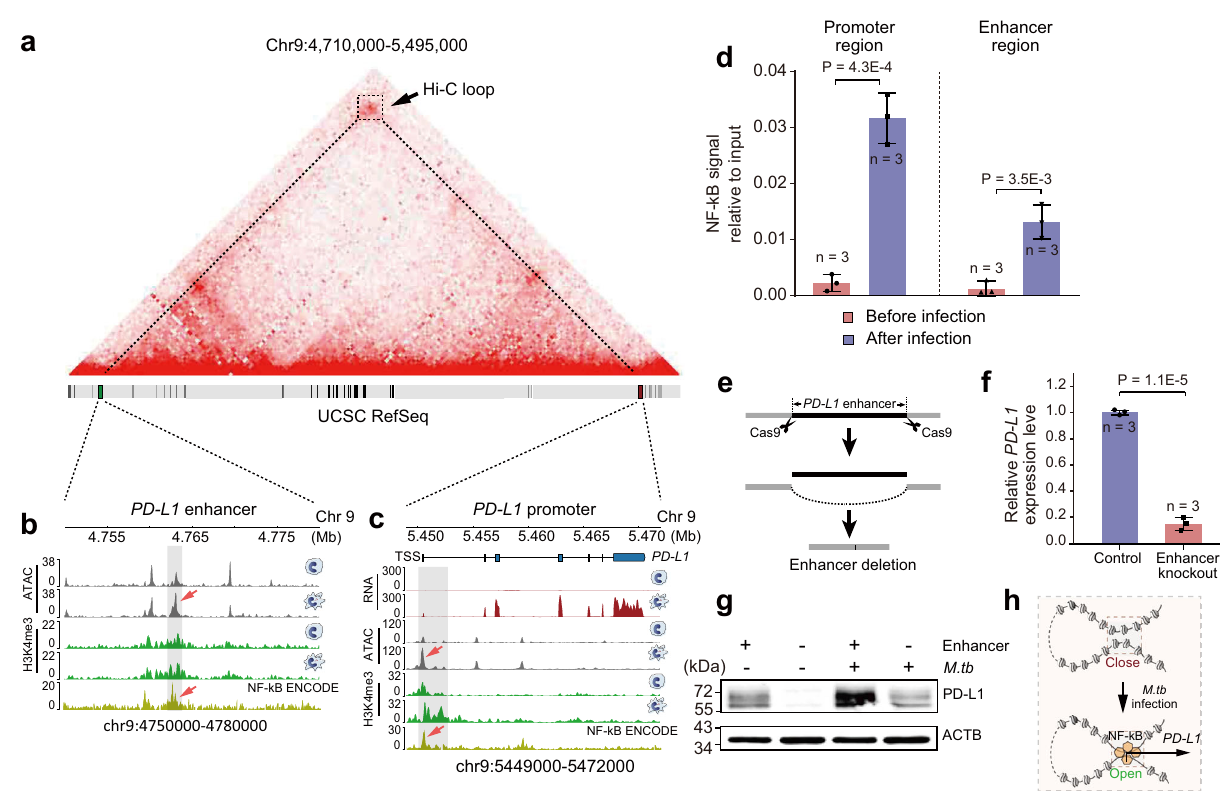
Fig. 6 | Functional identi fi cation of PD-L1 enhancer. a Interaction of the PD-L1 enhancer and promoter in the Hi-C matrix. b , c Genome Browser view of RNA expression levels, chromatin accessibility, and histone modi fi cations at the PD-L1 gene and enhancer regions in Thp1-macro and Thp1- M.tb cells. NF- κ B ChIP-seq peaks(ENCODE,GM15510cellline)andstrengthenedATAC-seqpeaksweremarked by arrows. d ChIP-qPCR validation of the NF- κ B (P65) enrichment on the PD-L1 enhancer and promoter regions. The amount of immunoprecipitated DNA in each sample is represented as signal relative to the total amount of input chromatin ( y -axis). Error bars show mean±SD (standard deviation), n =3 biologically